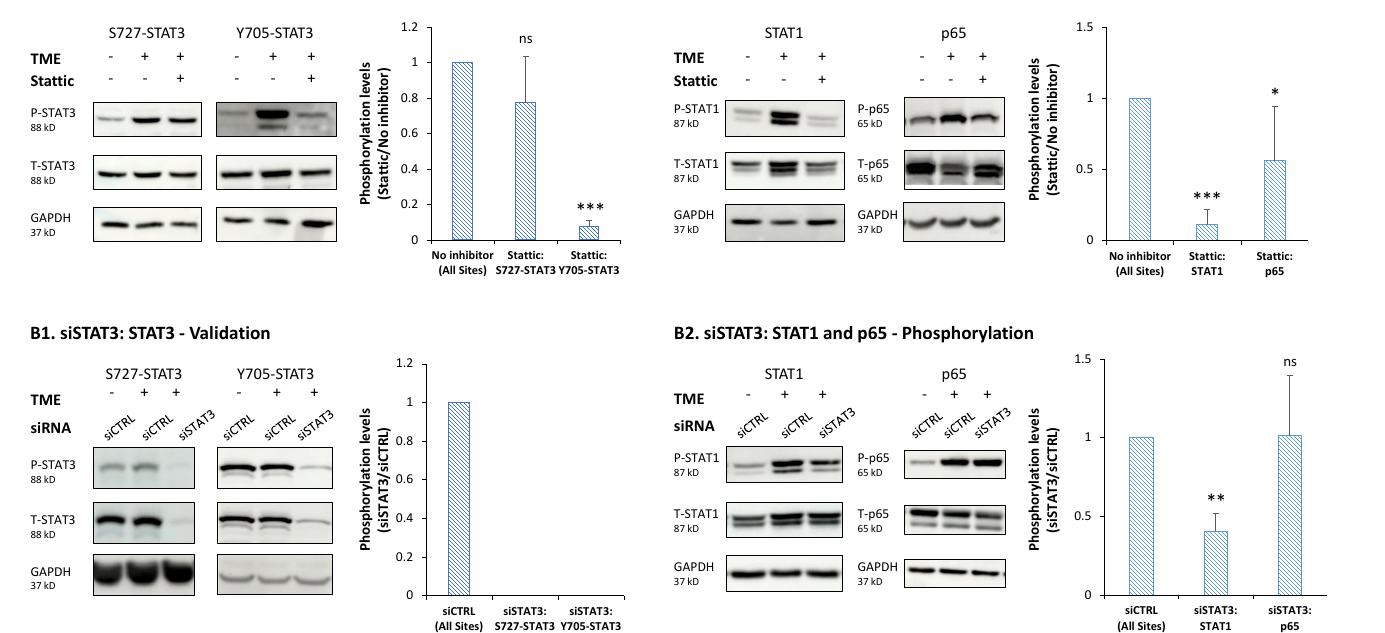
Figure 8. Upon TME Stimulation, stattic and siSTAT3 differently affect STAT1 and p65 activation in MCF-7 cells: the effects of the STAT3 inhibitor stattic and of STAT3 KD by siSTAT3 on STAT3, STAT1 and p65 activation were determined in MCF-7 cells that were exposed to TME Stimulation (TME; concentrations as described in Figure 1) or treated by a vehicle control. ( A ) The cells were incubated with stattic (5 µ M) or its vehicle for two h prior to TME stimulation and also during stimulation (as described in Figure 5). ( A1 ) Phosphorylation levels of S727-STAT3 and Y705-STAT3. The phosphorylation levels of S727-STAT3 were determined after 15 min of TME Stimulation, by WB analyses (based on the findings of Figure 4B1); Y705-STAT3 phosphorylation levels were determined after 96 h of TME Stimulation, by WB analyses (based on the findings of Figure 4B2). ( A2 ) STAT1 and p65 phosphorylation levels. The phosphorylation levels of STAT1 were determined after 96 h of TME Stimulation, by WB analyses (based on the findings of Figure 7A1); the phosphorylation levels of p65 were determined after 15 min of TME Stimulation, by WB analyses (based on the findings of Figure 7A2). In all panels, the blots demonstrate the results of a representative experiment of n = 3, showing similar results. ( B ) The cells were transfected with siCTRL or siSTAT3 (as described in Figure 6). ( B1 ) Phosphorylation levels of S727-STAT3 and Y705-STAT3. For both sites, phosphoryla- tion levels were determined after 30 min of TME Stimulation, by WB analyses (and also after 96 h of TME Stimulation, as shown in Figure 6A). ( B2 ) STAT1 and p65 phosphorylation levels. STAT1 phosphorylation levels were determined after 96 h of TME Stimulation, by WB analyses (based on the findings of Figure 7A1); p65 phosphorylation levels, determined after 15 min of TME Stimulation, by WB analyses (based on the findings of Figure 7A2). The STAT1 and p65 blots demonstrate the results of a representative experiment of n = 3, showing similar results. In all panels, the bar graphs demonstrate an average ± SD of n = 3 experiments for each phosphorylated protein, demonstrating fold change between stattic/siSTAT3 and control cells. *** p < 0.001. ** p < 0.01. * p < 0.05. ns, not significant. The uncropped blots are shown in Figure